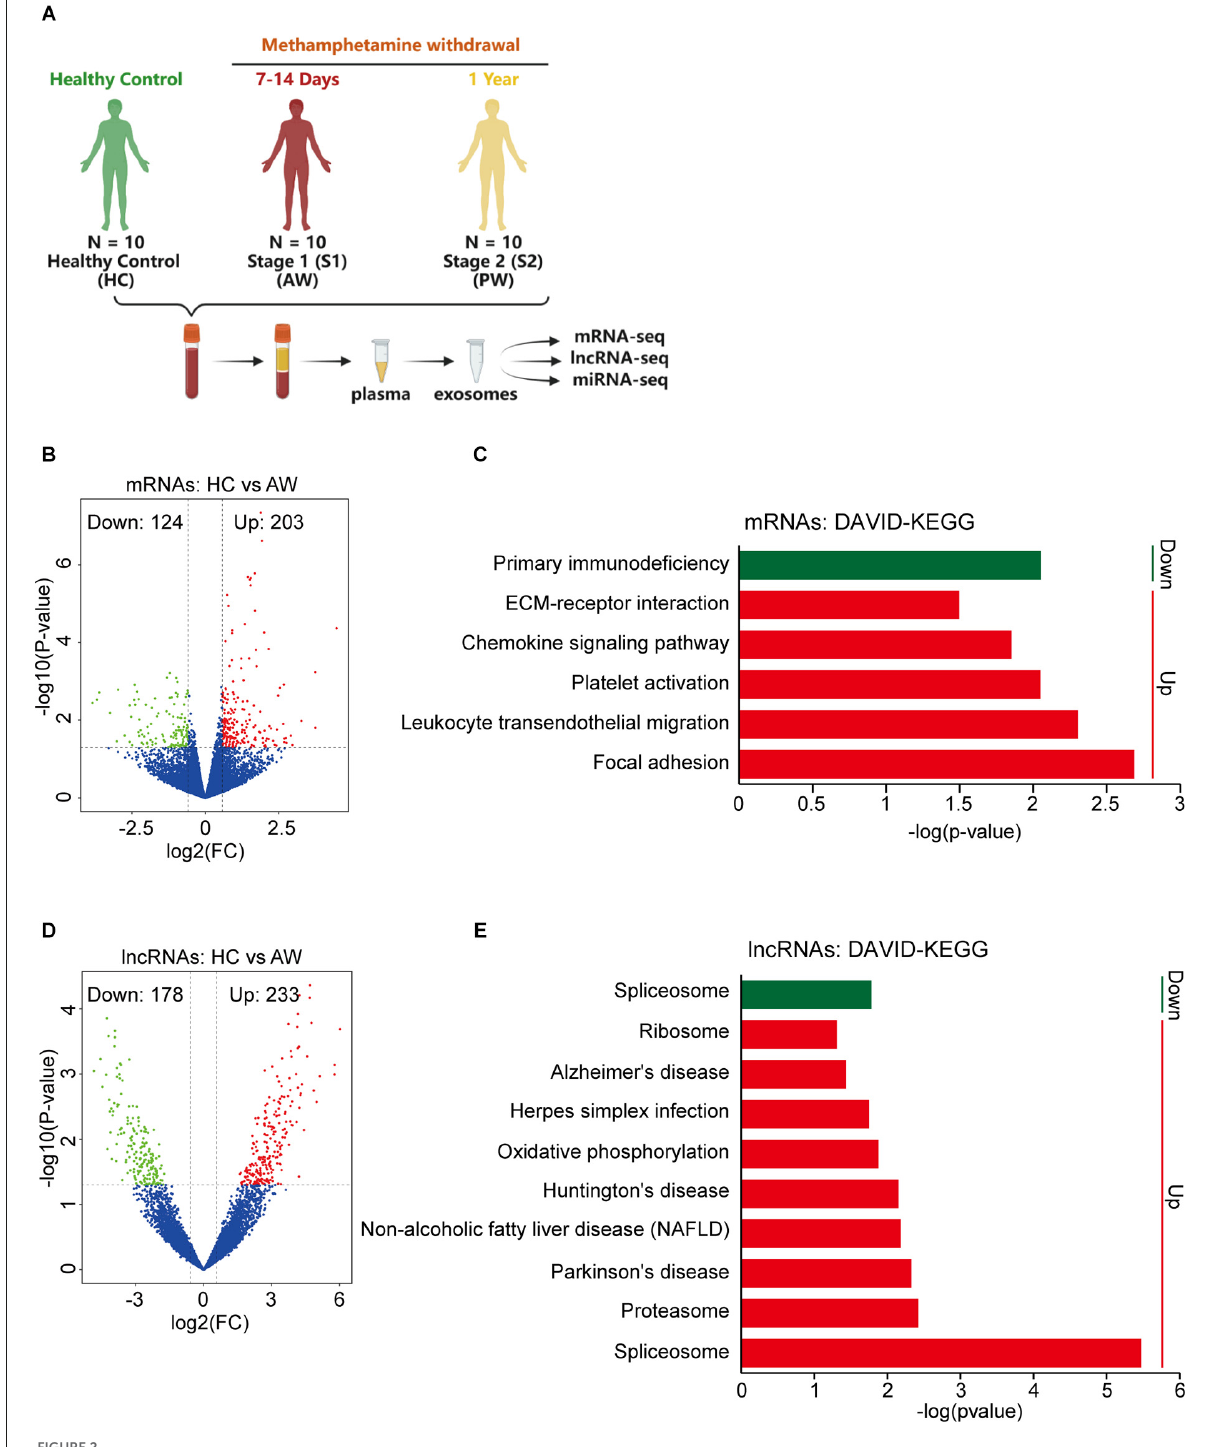
FIGURE2 Differential expression of exosomal mRNAs and lncRNAs at acute METH withdrawal (AW) stage. (A) Sample collection and high-throughput sequencing processing schedule for exosomal transcriptome alterations in MUD patients. (B) Volcano plot showed the different expression (DE) mRNAs at the AW stage. (C) DAVID-KEGG analysis of DE mRNAs at AW stage. (D) Volcano plot showed the DE lncRNAs at AW stage. (E) DAVID-KEGG analysis of DE lncRNAs at AW stage. Green represents downregulated genes; Red represents upregulated genes. mRNA, messenger